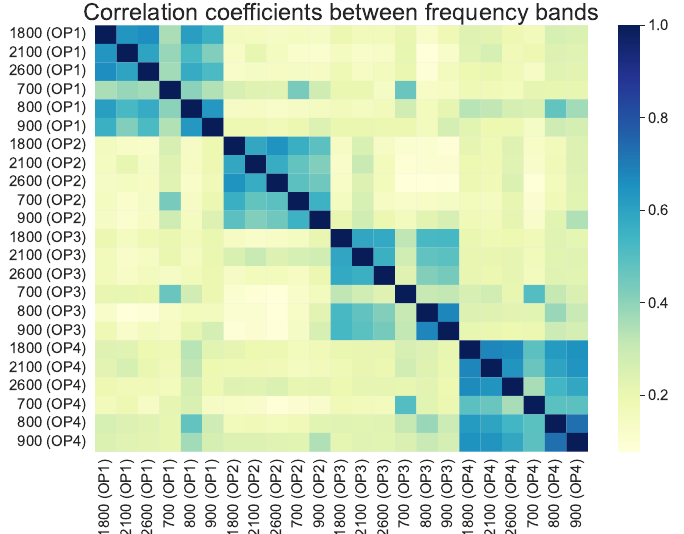
Figure 4. Heatmap of the correlation between bands of different operators. According to guidelines given by ICNIRP [23], the reference levels for EMF exposure from 100 KHz to 300 GHz in the whole body case are frequency-dependent since they depend on the equivalent surface of the body, which is linked to the frequency. For example, reference limits at frequencues 400 MHz ( L 4 MHz ) and 2 GHz ( L 2 GHz ) are 27.5 and 61 V/m